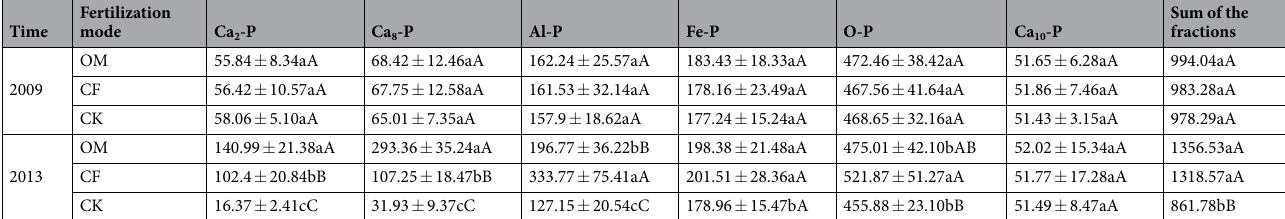
Table 4. Changes in the concentration of inorganic Pi in the surface soil layer (0–20 cm) as affected by different fertilization modes (mg·kg − 1 ). Note: The different lowercase and uppercase letters in the same column for each year indicate a significant difference at the 0.05 and 0.01 levels,